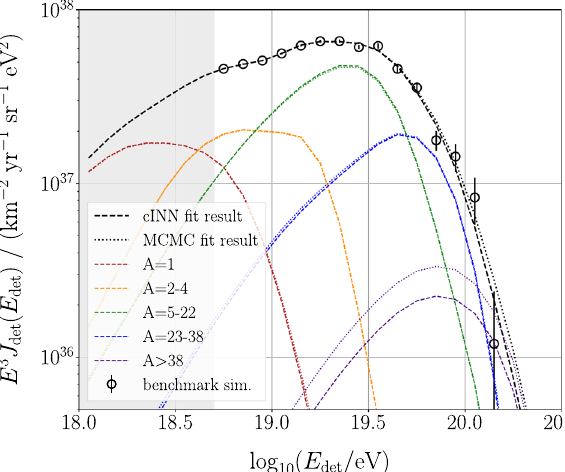
Fig. 7 Modeled energy spectra for the cINN (dashed) and the MCMC (dotted) using the predicted source parameters as given in Figs. 5 and 6. Both methods are able to find a set of source parameters that describe the benchmark simulation energy spectrum, depicted as black symbols including Poissonian error bars. Also, the individual element contribu- tions predicted at Earth, shown in different colors for different mass groups, agree with the ones of the benchmark simulation in Fig.